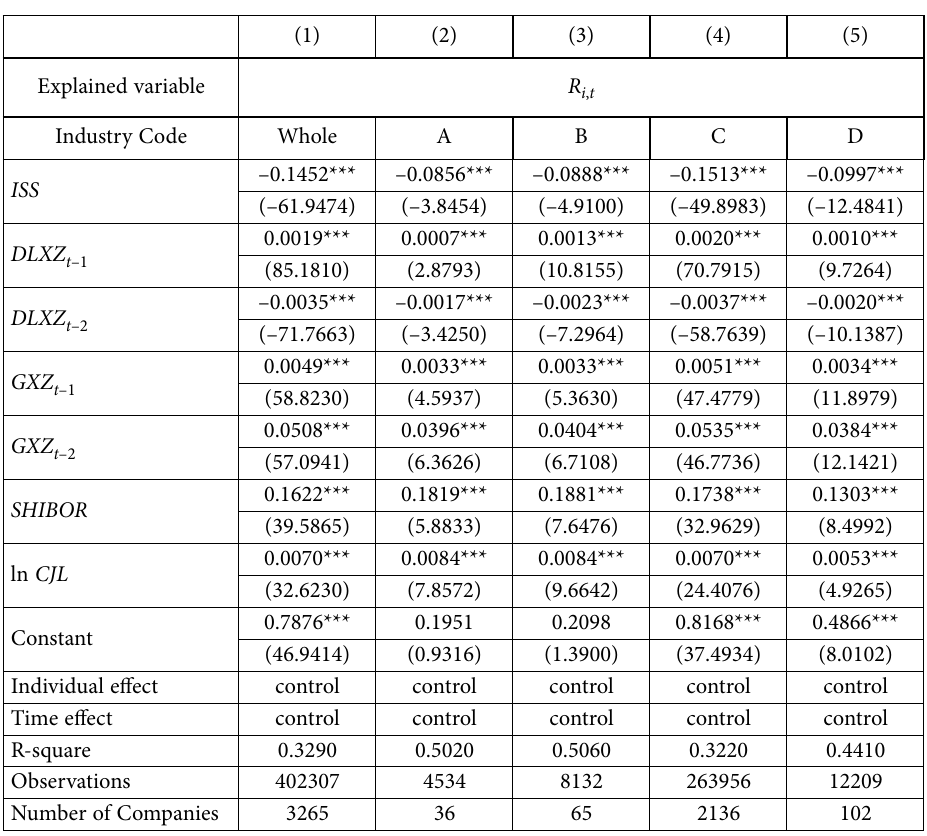
Table 8. Influence of information infection on stock market 1